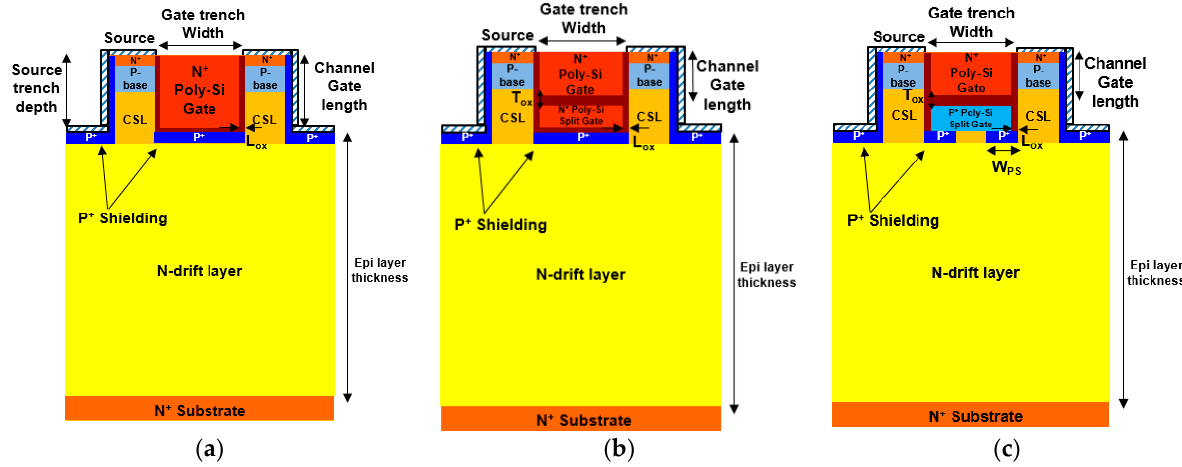
Figure 1. Schematic cross-sectional view of ( a ) Conventional Double Trench MOSFET (Con-DTMOS), ( b ) Split Gate Double Trench MOSFET (SG-DTMOS), and ( c ) Split Heterojunction Gate Double Trench MOSFET (SHG-DTMOS). Table 1. Structure parameters of each device.